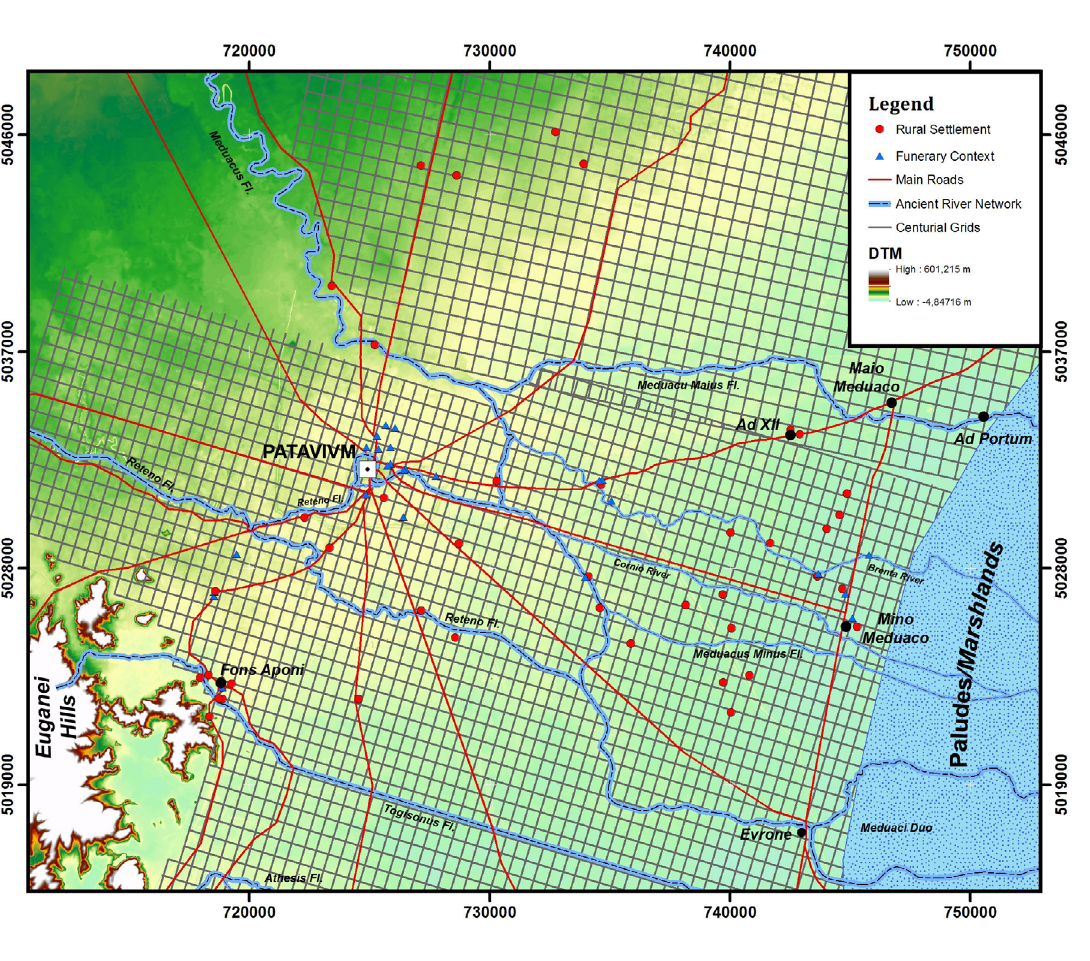
Fig. 11 The road network around Patavium between the 3rd and 4th century